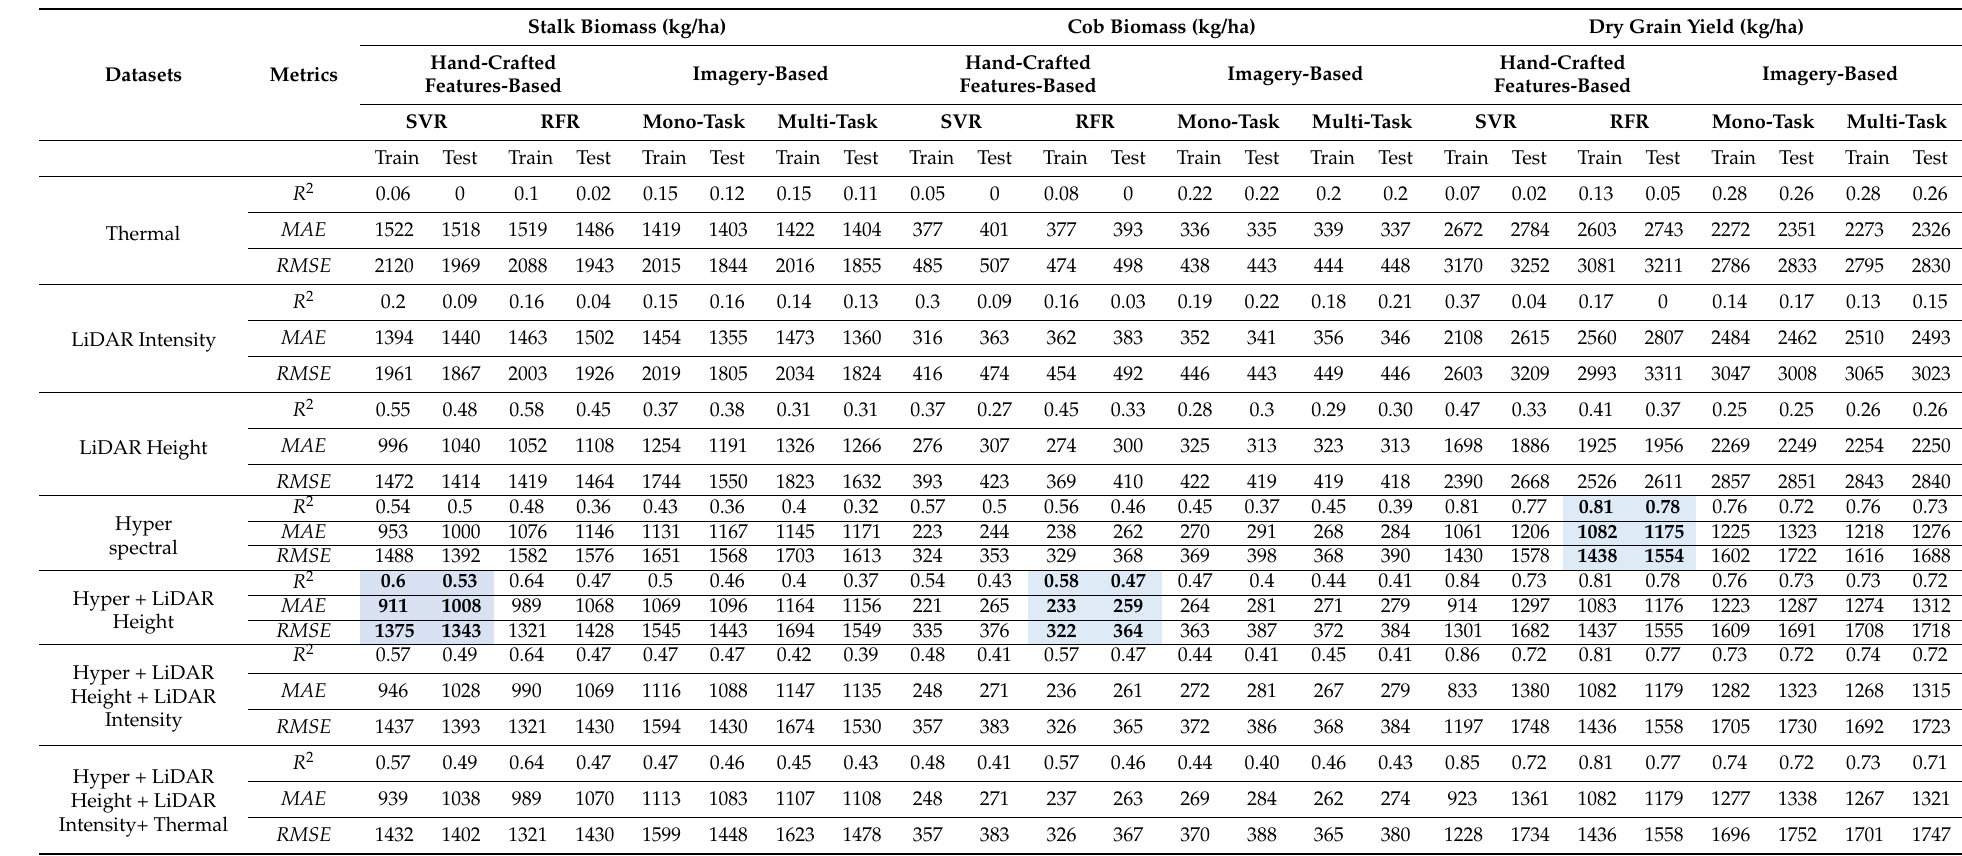
Table A1. Results of maize phenotypic prediction performed by different data sources and